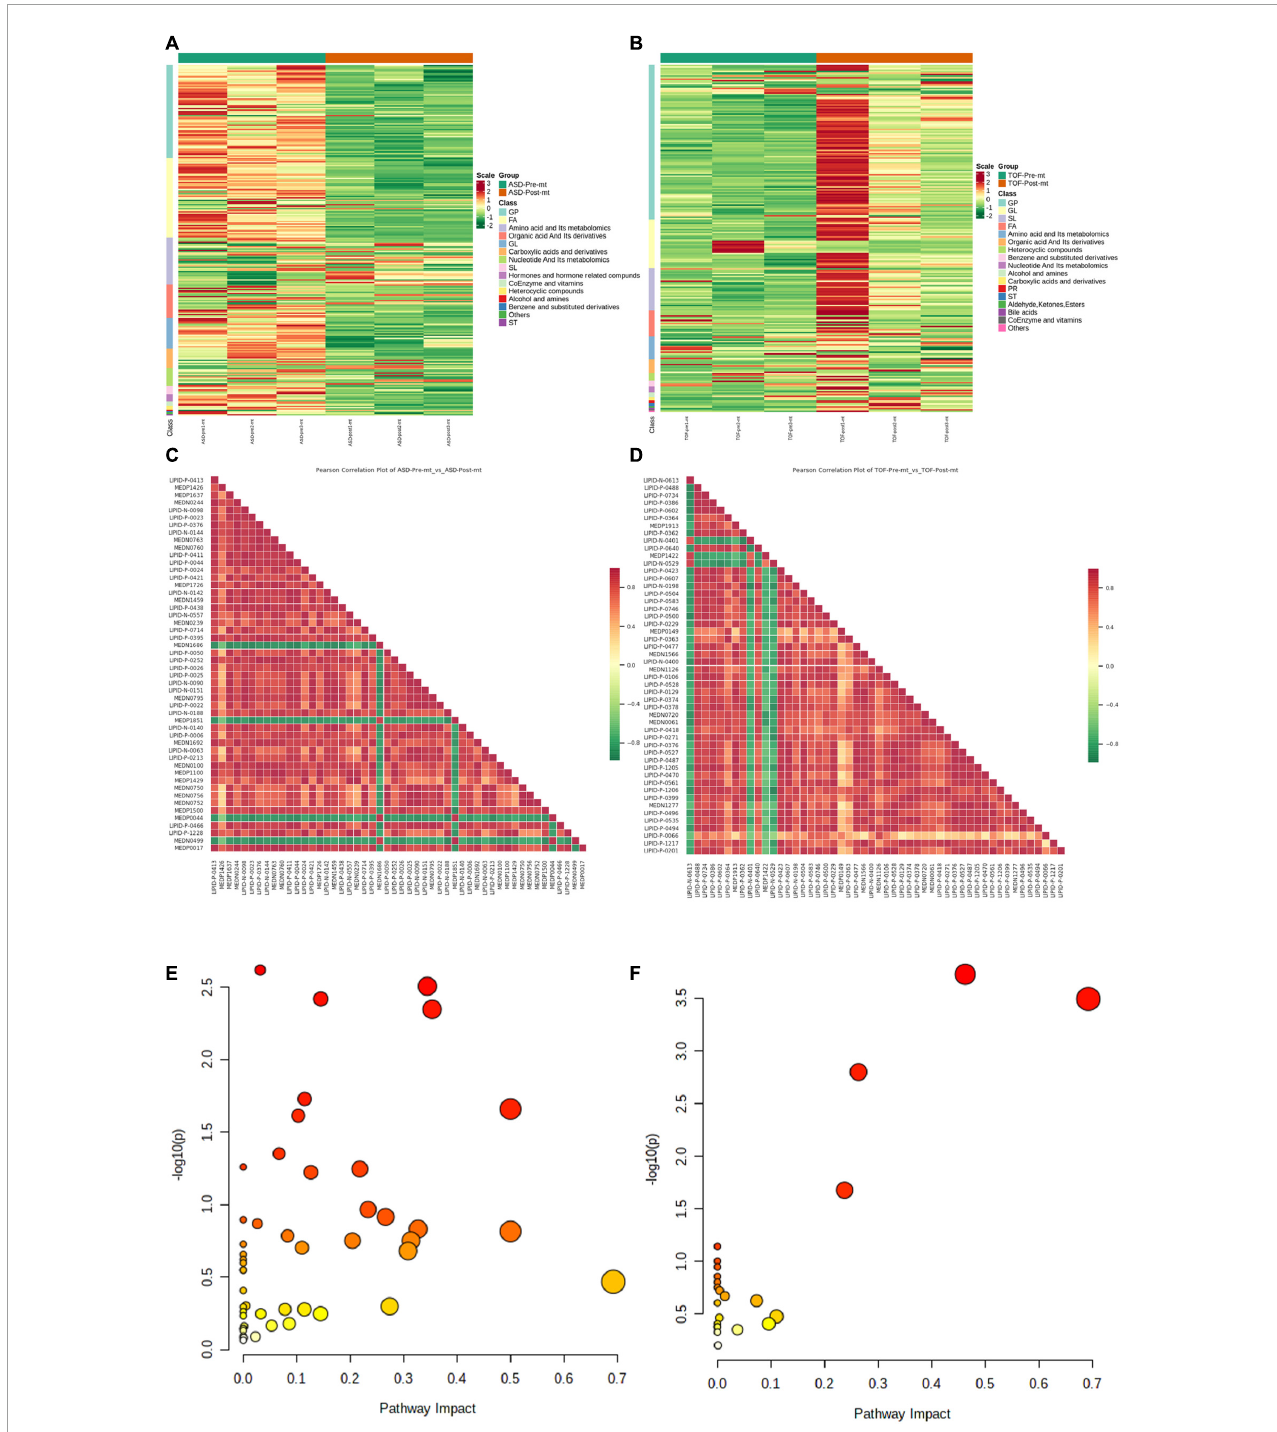
FIGURE6 Differential metabolite enrichment analysis. (A) Heatmap of differential metabolites in atrial septal defect (ASD) samples. (B) Heatmap of differential metabolites in tetralogy of fallot (TOF) samples. (C) Heatmap of differential metabolite correlations in ASD samples. (D) Heatmap of differential metabolite correlations in TOF samples. (E) Metabolic pathways of ASD. (F) Metabolic pathways of